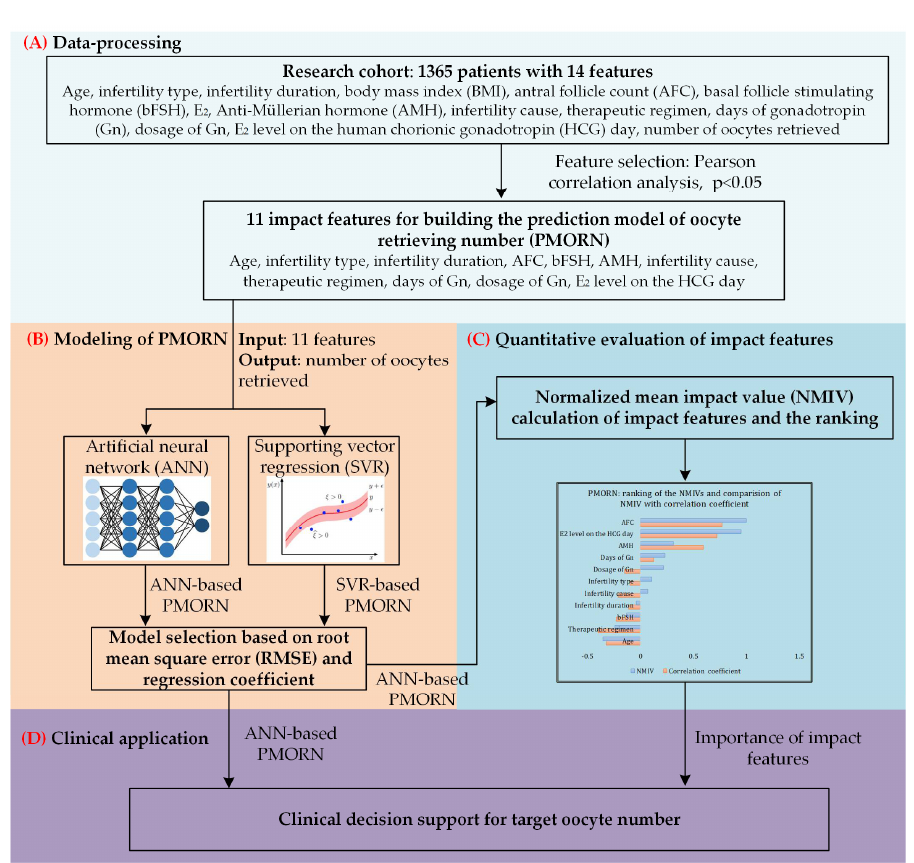
Figure 1. The overall framework of our study. ( A ) Data-processing toward the research cohort with 1365 sets of clinical data; Pearson correlation analysis is conducted to identify the impact features with significant correlation value. ( B ) Based on the two types of methods, ANN and supporting vector regression (SVR), two prediction models of the number of oocytes retrieved are built; the model selected is based on the training and prediction results. ( C ) Quantitative evaluation of the impact features, and ranking the importance of them. ( D ) Clinical application of the proposed model. Table 1. Demographics and clinical properties of the research